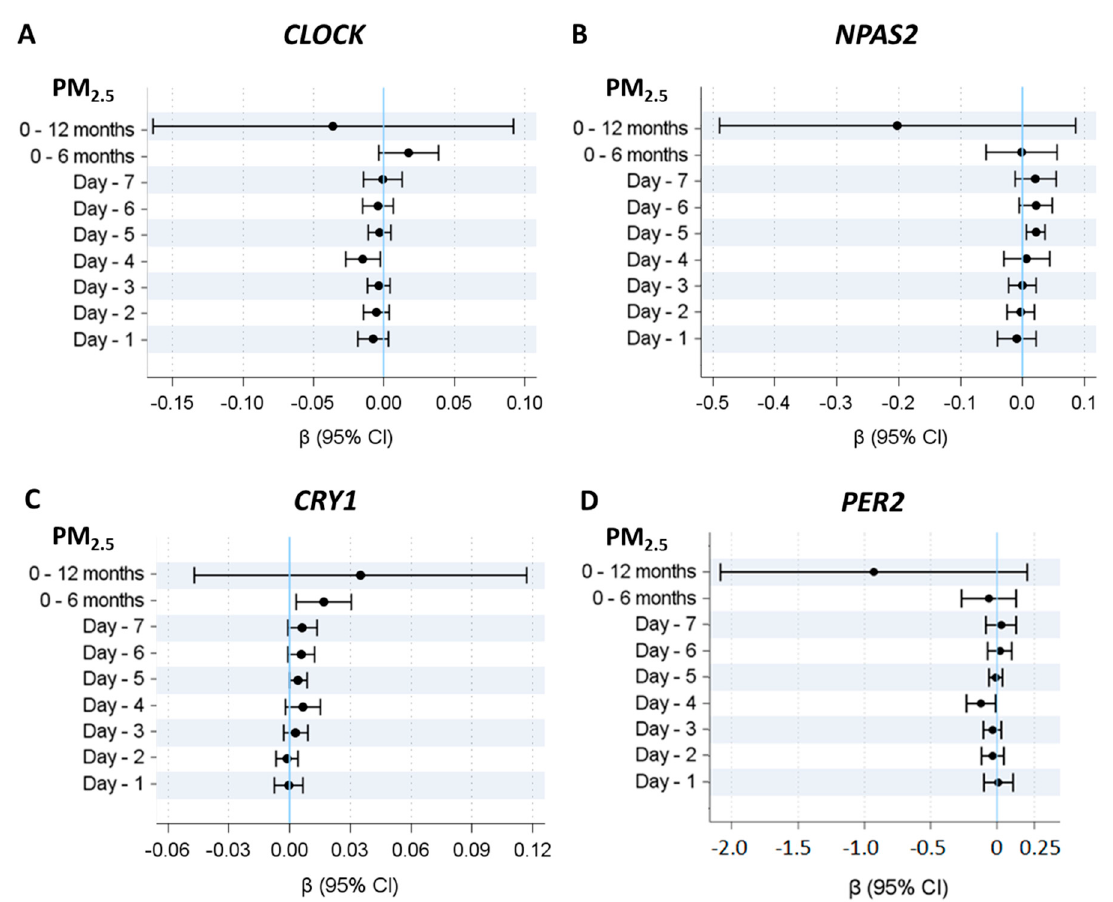
Figure 1. Association between PM 2.5 exposure and clock gene methylation. Linear mixed-effect regression models were adjusted for age, sex, smoking habits, warm/cold months (months with heaters switched on/off), run, position and plate. Panel A, B, C and D represent beta regression coefficients and 95% CI for CLOCK, NPAS2, CRY1 , and PER2 methylation, respectively.